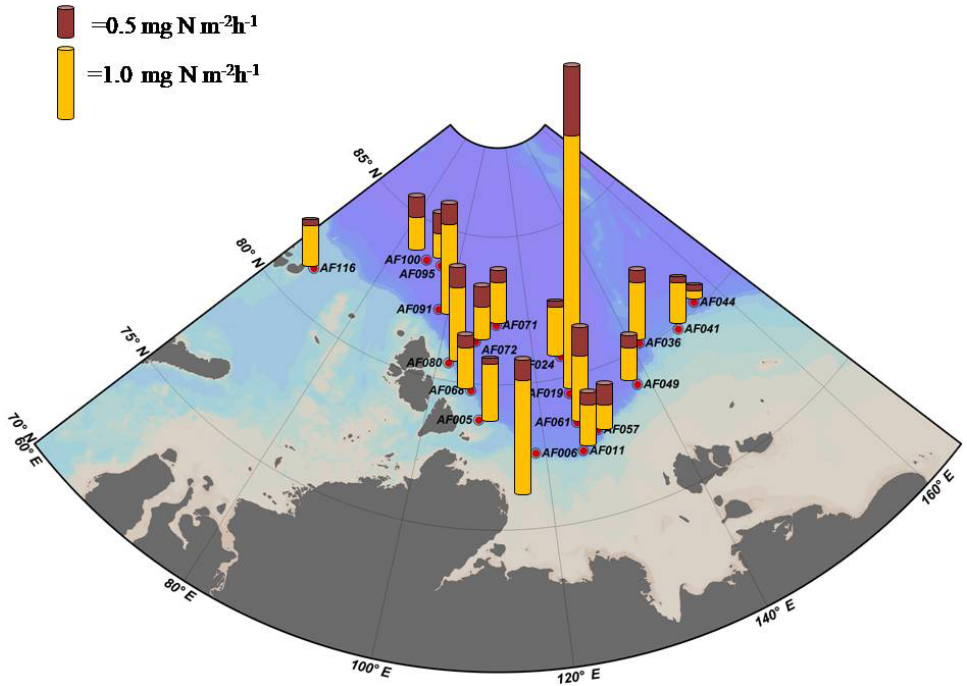
Figure 4. The depth-integrated small phytoplankton NO − indicate the small phytoplankton NO −